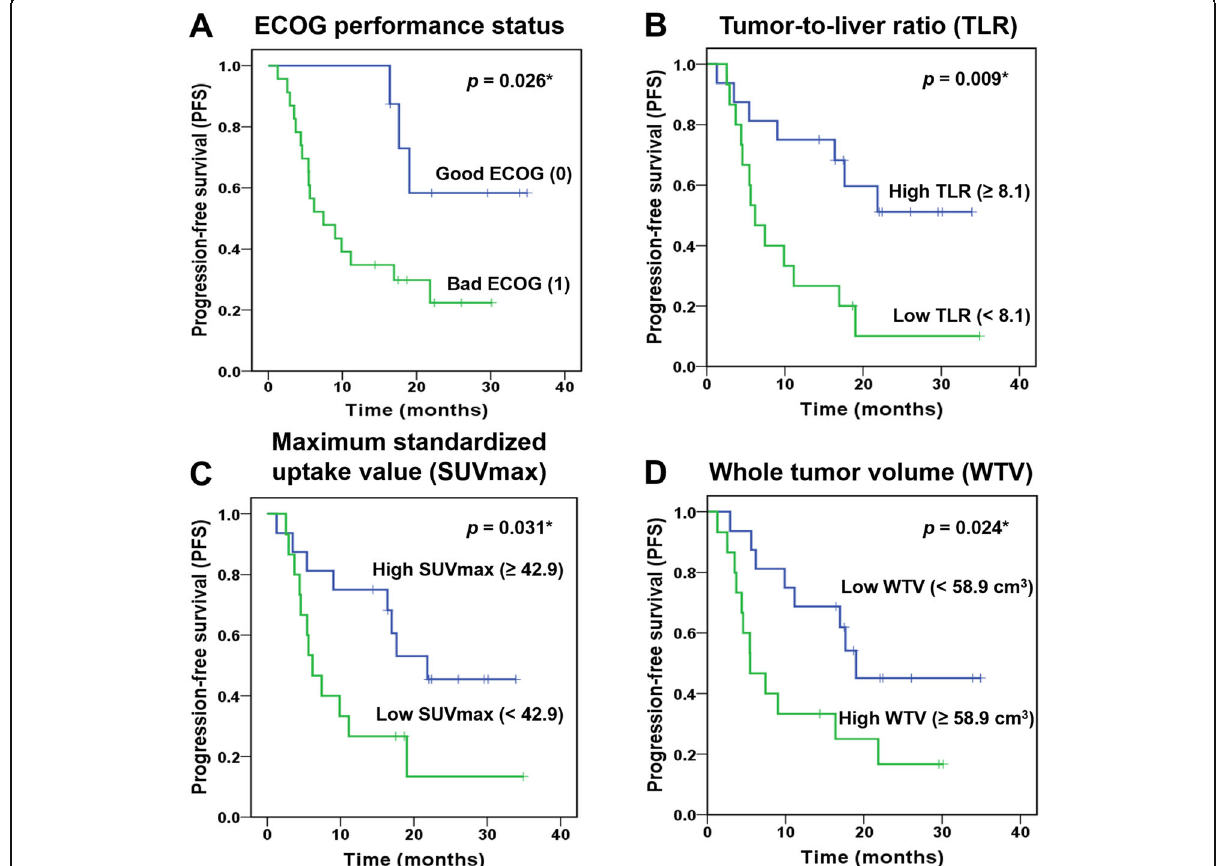
Fig. 2 Kaplan-Meier analysis and log-rank test for PFS prediction after lanreotide therapy. a ECOG performance status ( p = 0.026), b TLR ( p = 0.009), c SUVmax ( p = 0.031), and d WTV ( p = 0.024) demonstrated significant